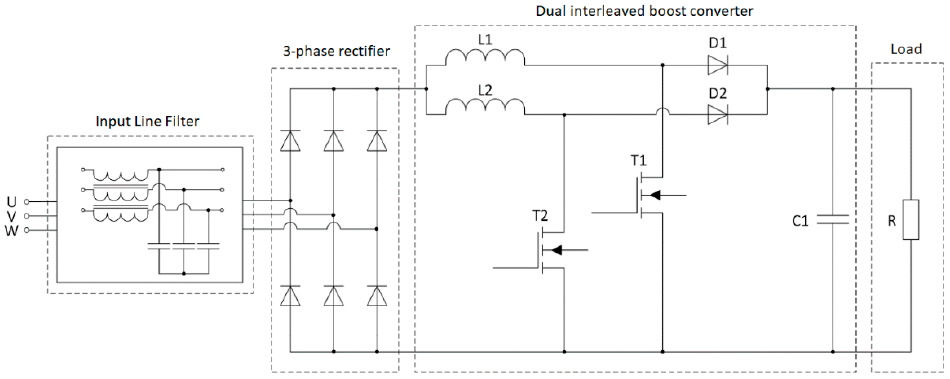
Figure 1. Main circuit of the three-phase power factor correction (PFC) interleaved converter.